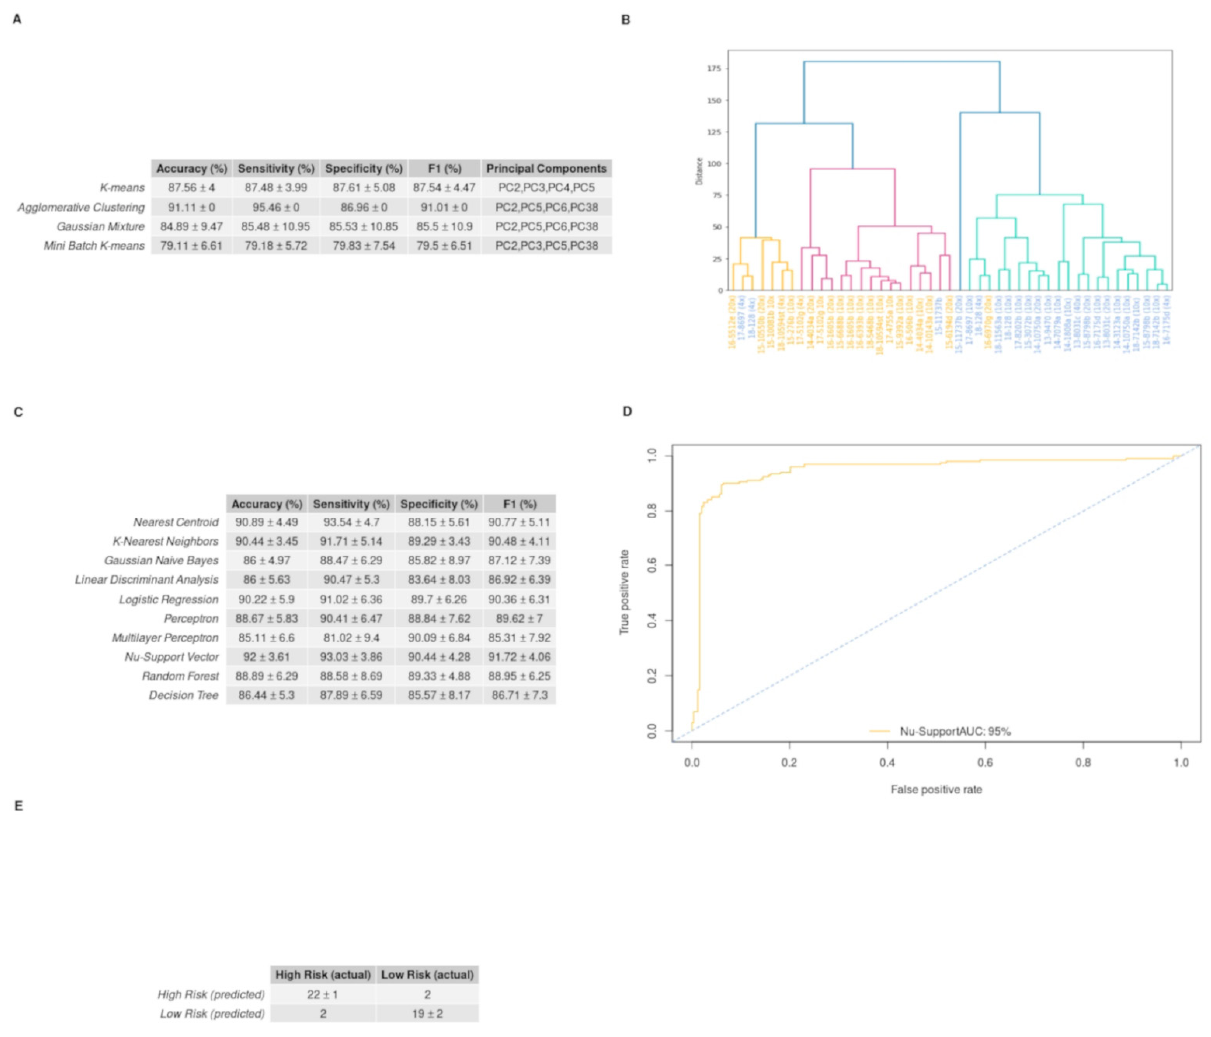
Figure 6. Unsupervised and supervised machine learning algorithms’ performance on discriminating the low- and high-risk groups employing the immunohistochemical (IHC) stained images from GBM biopsy material: ( A ) Dendrogram produced from hierarchical clustering employing Euclidian distance and Ward’s linkage for the selected principal components. On the x -axis, the samples of the high-risk images are colored blue, while the samples of the low-risk images are colored orange. The 1st cluster, which consists of the orange and the red groups, represents the low-risk cluster, while the turquoise group along with the 22nd (15-11737b (20 × )) sample constitutes the high-risk cluster (sensitivity is the ability of the models to predict high risk and specificity the ability to predict low risk); ( B ) The ROC curve of the supervised model, with the best performance in discriminating the two groups, after 10 repetitions of the bootstrap method. The area under the curve is equal to